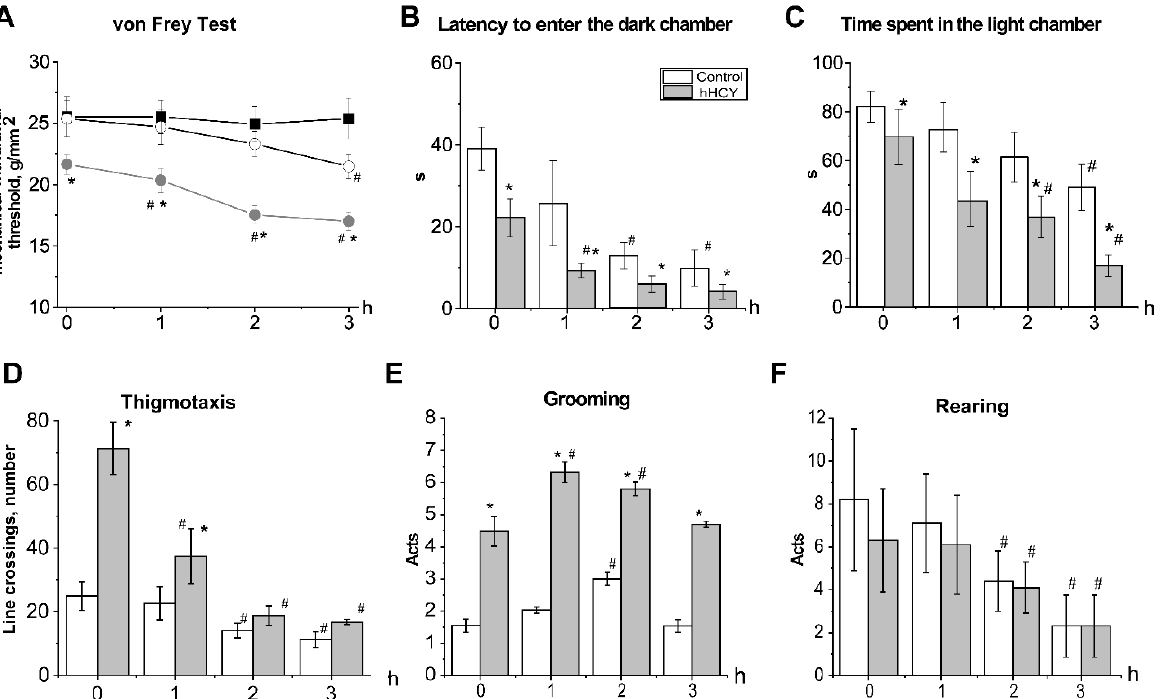
Figure 1. Effects of acute nitroglycerine (NTG) administration on mechanical sensitivity and behavior in the light-dark transition test and open field. ( A ) Mechanical withdrawal threshold of the plantar surface of the hind paw of rats, control (open circle), hHCY group (grey circle) and vehicle (black square) groups before (0) and during 3 h after NTG administration. ( B ) Latency to enter the dark chamber and ( C ) time spent in the light chamber, of rats from the control (white column) and hHCY (grey column) groups before (0) and during 3 h of NTG administration. The number of line crossings in the peripheral area of the open field or thigmotaxis ( D ), grooming acts ( E ) and rearing ( F ) of rats from control (white columns) and hHCY groups (grey columns) before (0) and during three hours of NTG administration. * p < 0.05 compared to the control group, # p < 0.01 compared to the initial values.